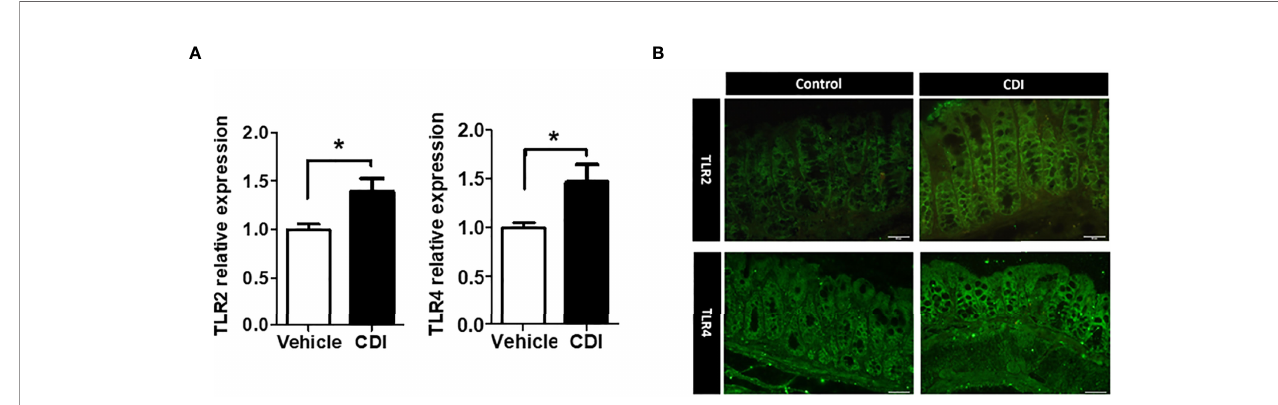
FIGURE 1 | The expression of TLR2 and TLR4 increased in wild-type mice with CDI compared with uninfected mice (vehicle) in protein expression (A) and in IHC staining (B) . Values are expressed as means ± SEMs (* P < 0.05).